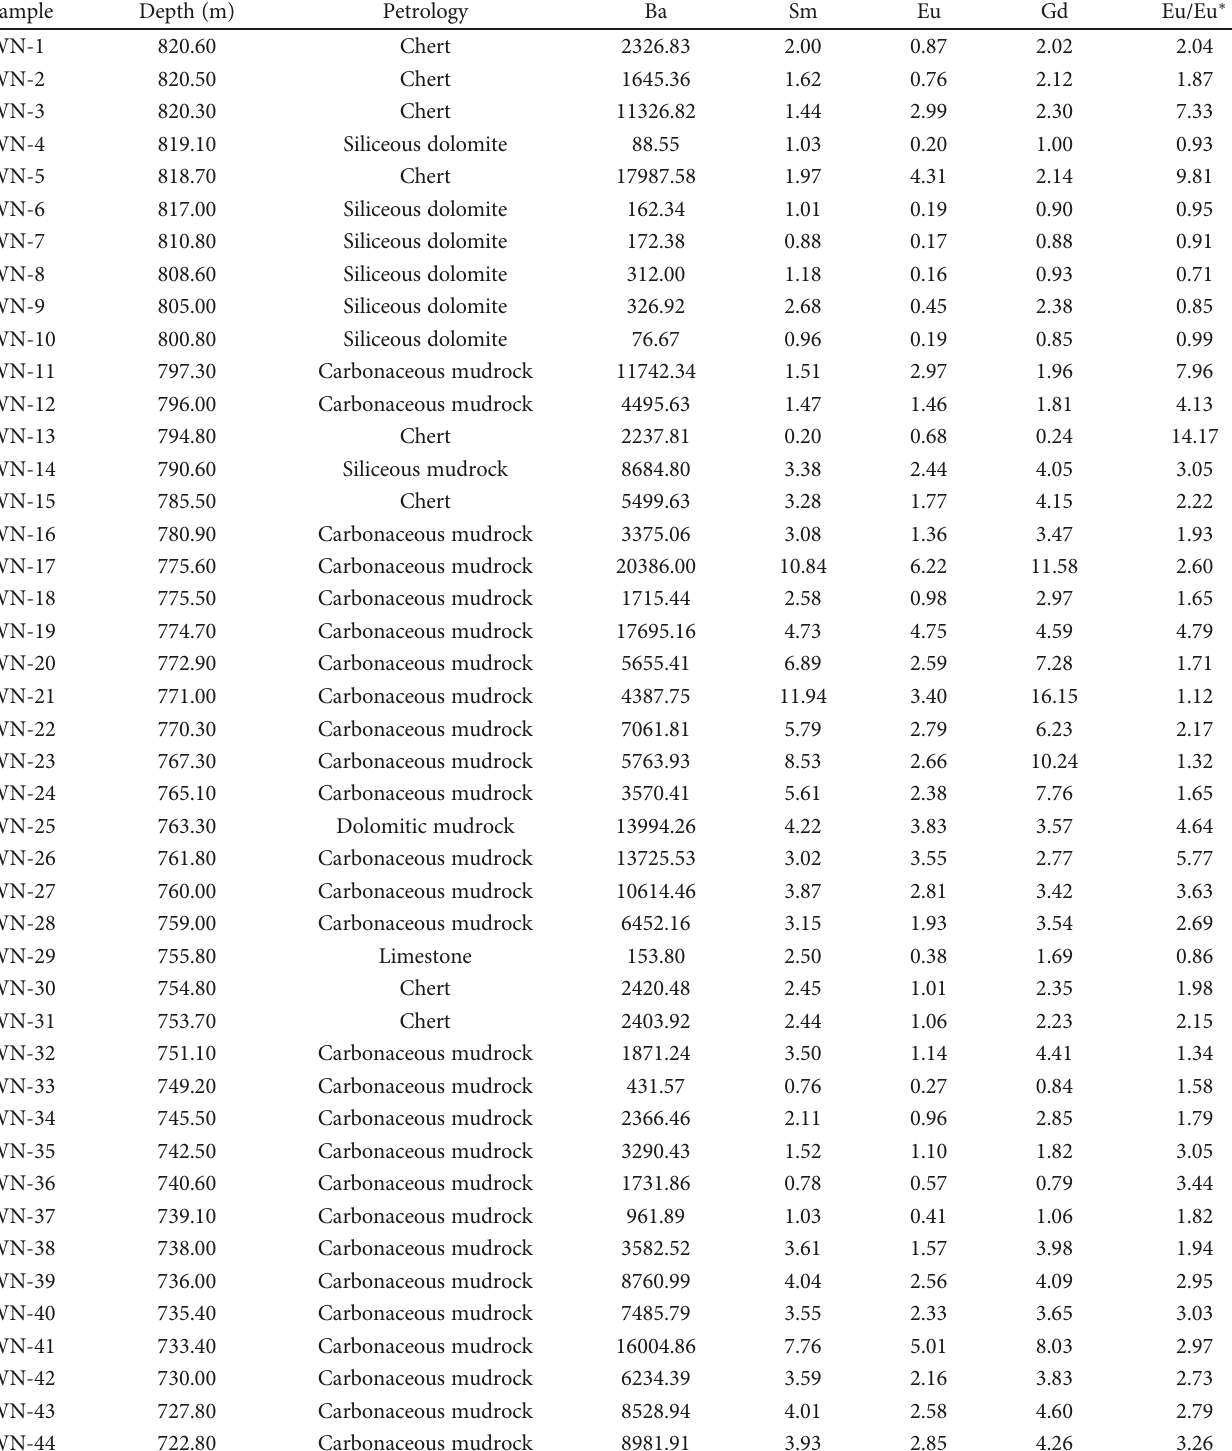
Table 2: Concentrations of Ba and selected REE elements of mudrock, chert, and carbonate samples in Batch 1. Sample Depth